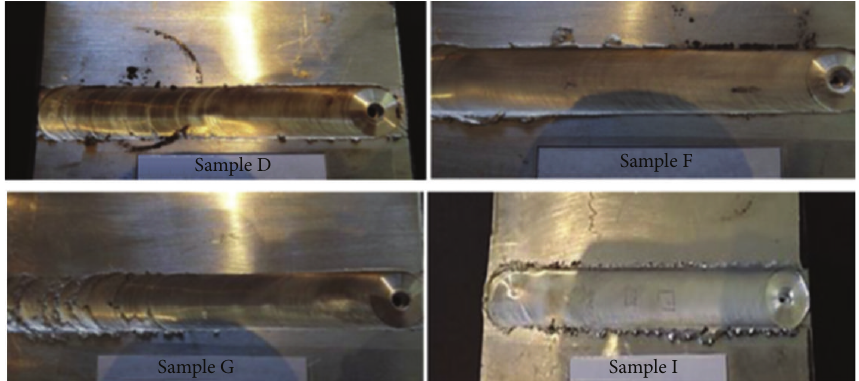
Figure 8: Photographs of samples D, F, G, and